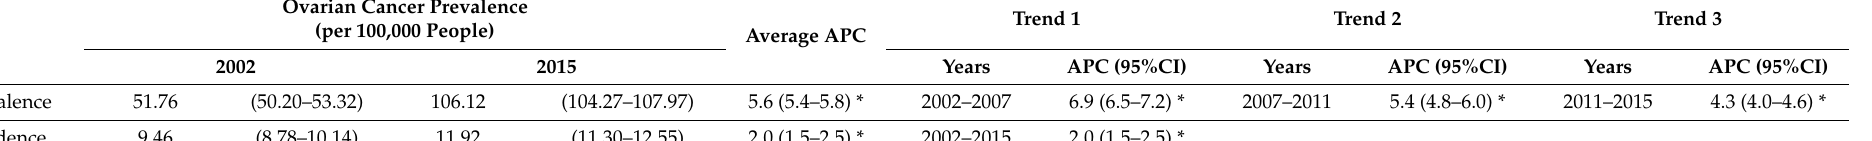
Table 4. Joinpoint analysis of ovarian cancer prevalence and incidence in Taiwan from 2002 to 2015. Ovarian Cancer